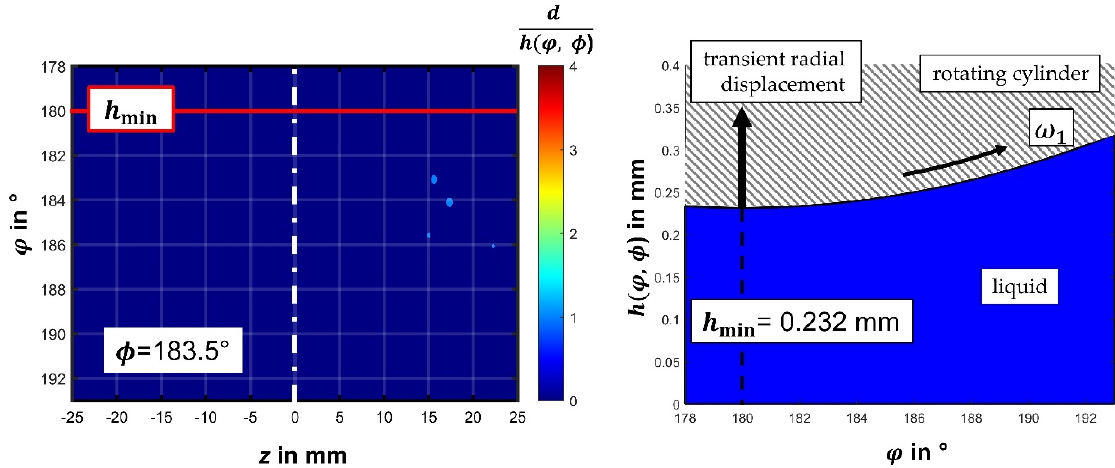
Figure 8. Bubble size in relation to local film thickness during phase 1, rotational angle φ = 183.5 ◦ after initiation of transient radial displacement, inception of bubbles by solely gas cavitation, fluid: paraffin containing 100% dissolved air.